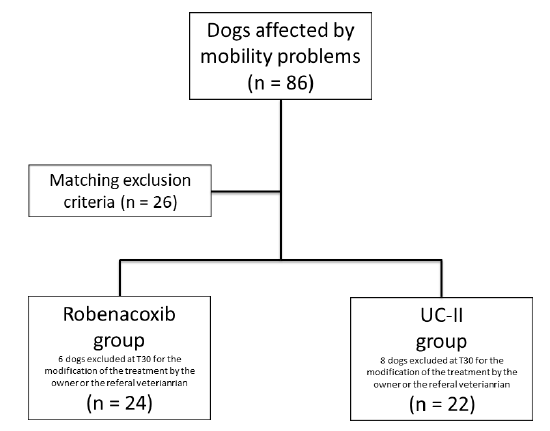
Figure 1. Flow chart concerning the population of dogs included in the study.